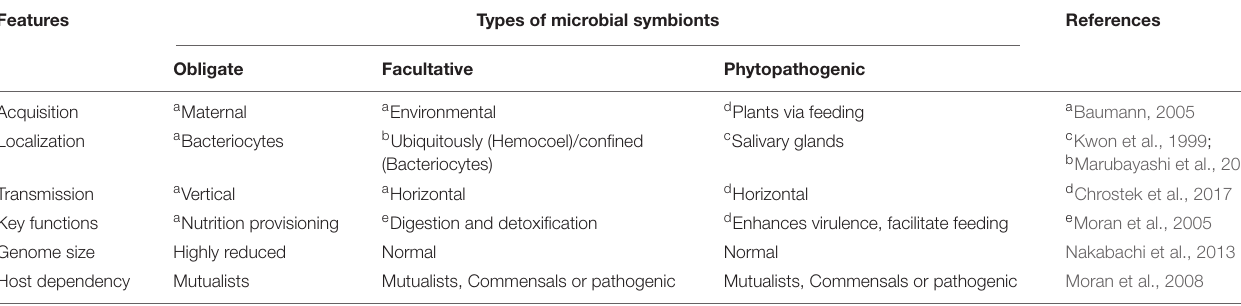
TABLE 1 | Types of microbial symbionts of insects and their